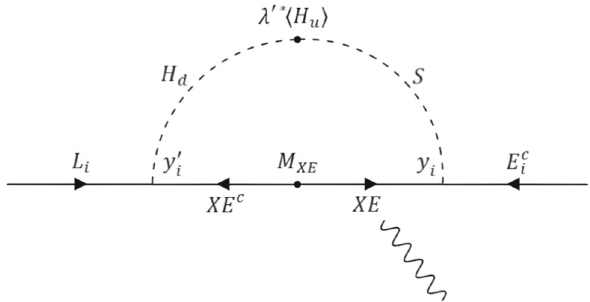
Fig. 2 Chirality flip Feynman diagram depicting the inclusion of the singlet S that couples with the ( XE , XE c ) of our Xl and Xl vector-like flippon multiplet